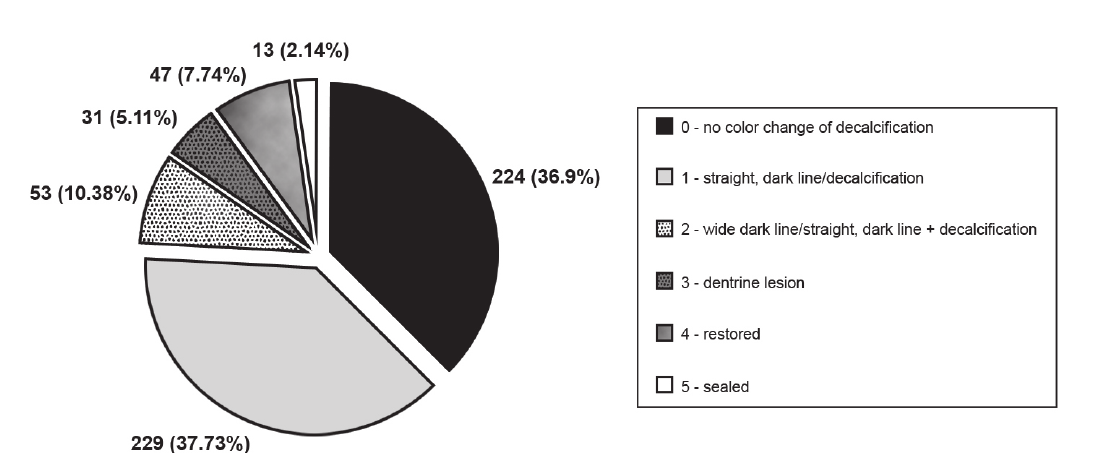
Figure 4- Distribution of evaluated teeth based on tooth groups (1 st premolar, 2 nd premolar, 1 st molar and 2 nd molar)